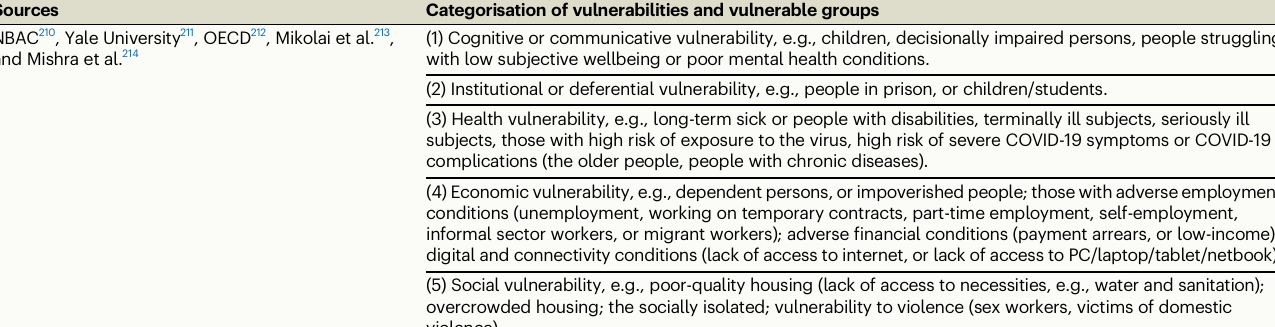
Table 3 | Categorisation of vulnerabilities and vulnerable groups in this research Sources Categorisation of vulnerabilities and vulnerable